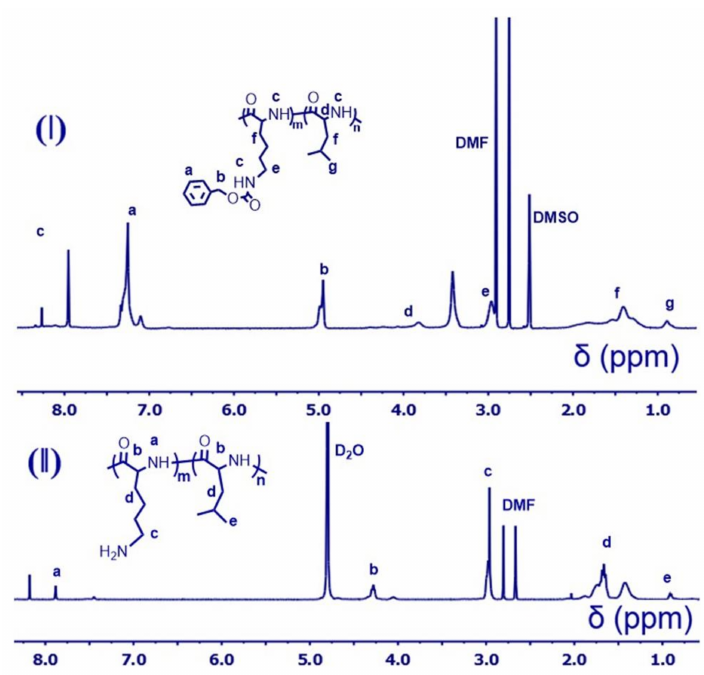
Figure 3. 1 H NMR spectrum of ( I ): poly( L -lysine(CBZ)) 50 - block -poly( L -leucine) 10 in DMSO-d 6 and ( II ): poly( L -lysine) 50 - block -poly( L -leucine) 10 in D 2